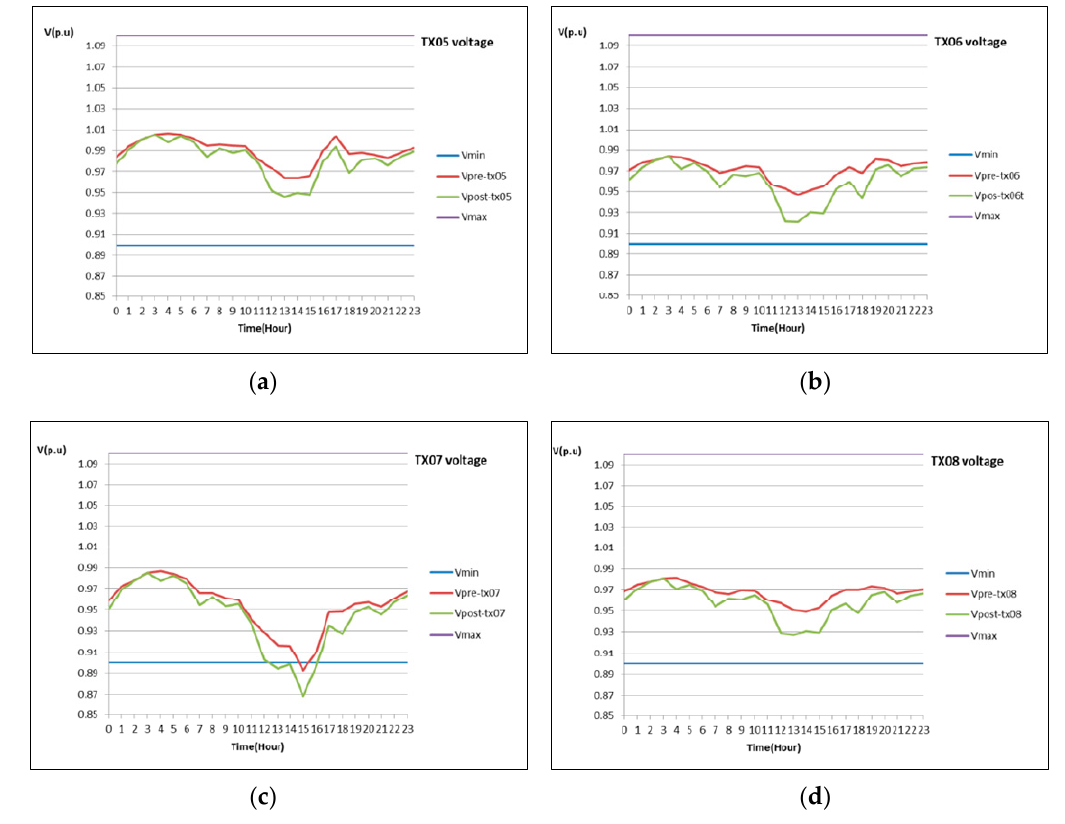
Figure 14. Voltage profile of feeder head before and after XFC installation on 20% penetration in area 2. ( a )TX05; ( b )TX06; ( c )TX07 and ( d )TX08